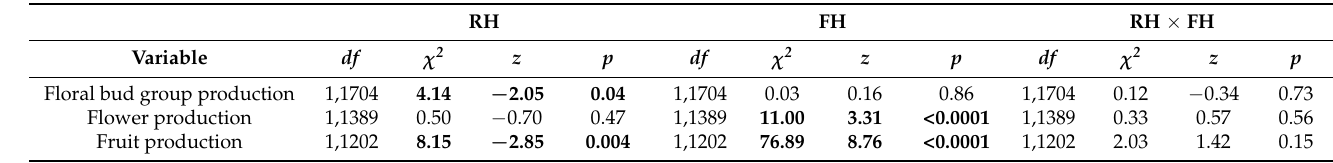
Table 1. Results of generalized estimating equation models (GEEs) for the effect of root herbivores (RH) and floral herbivores (FH) on plant reproductive traits development over time. Significant values ( P < 0.05) are highlighted in bold.